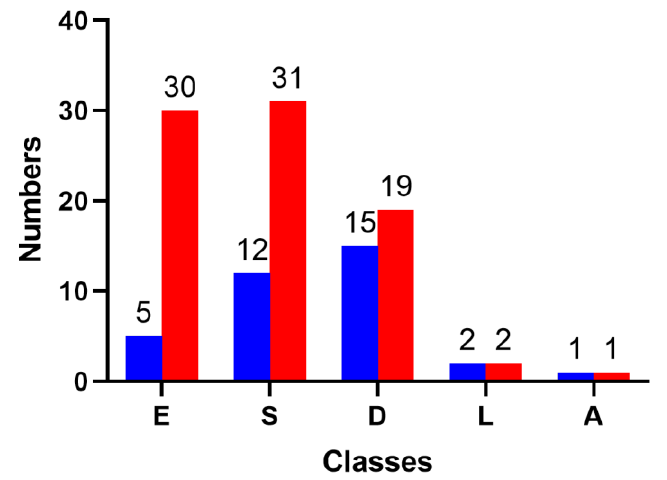
Figure 21. Taxonomy of endophytic fungi isolated from 2002–2022.